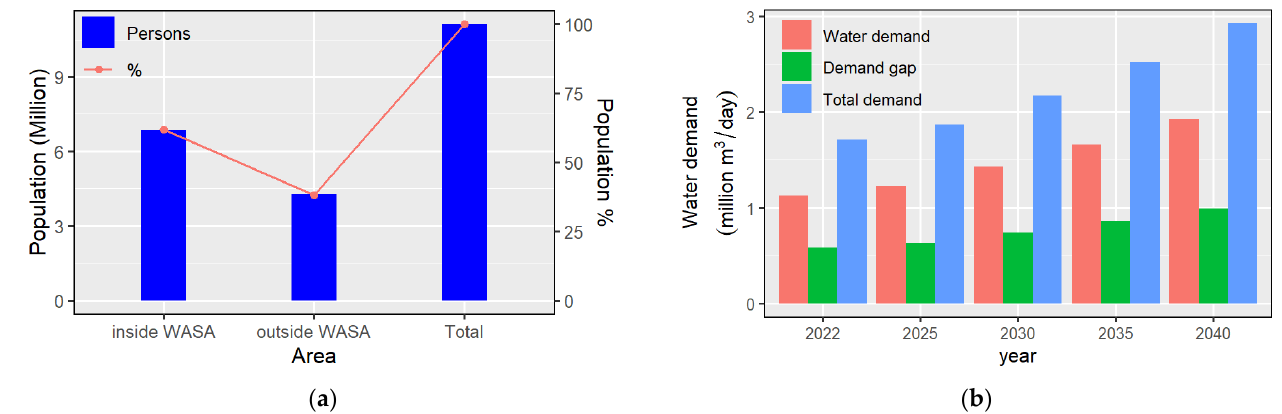
Figure 7. ( a ) Population inside and outside of the WASA supply area in Lahore; and ( b ) projected water demands up to